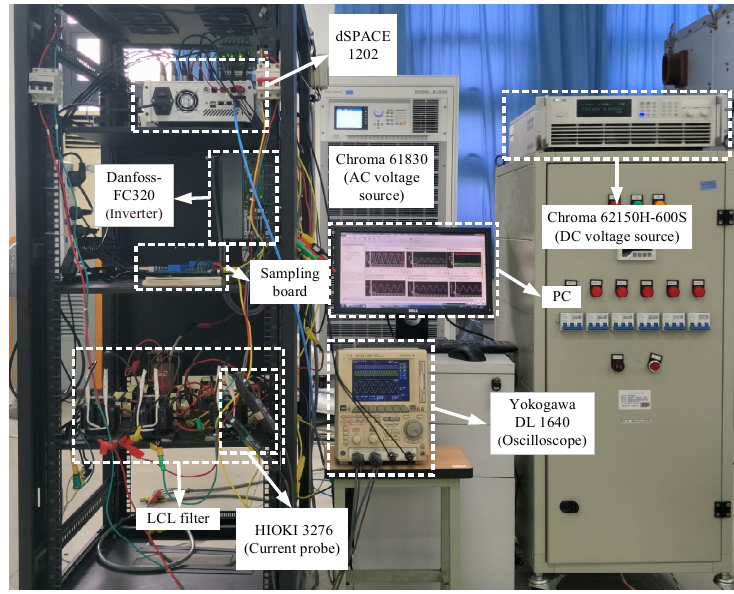
Figure 9. The experimental test setup.